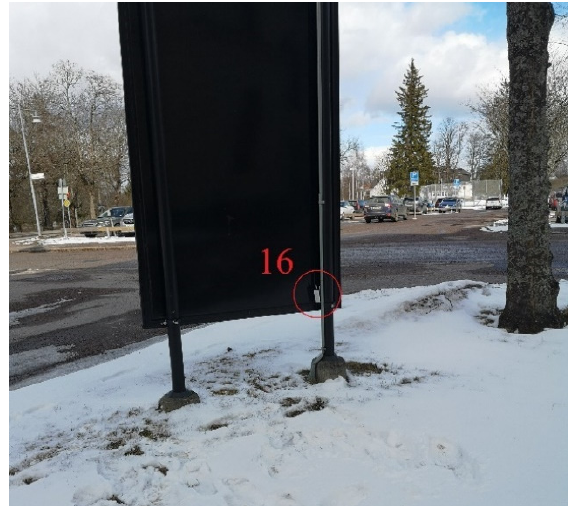
Figure 13. Placement of logger 16 behind a sign outside the